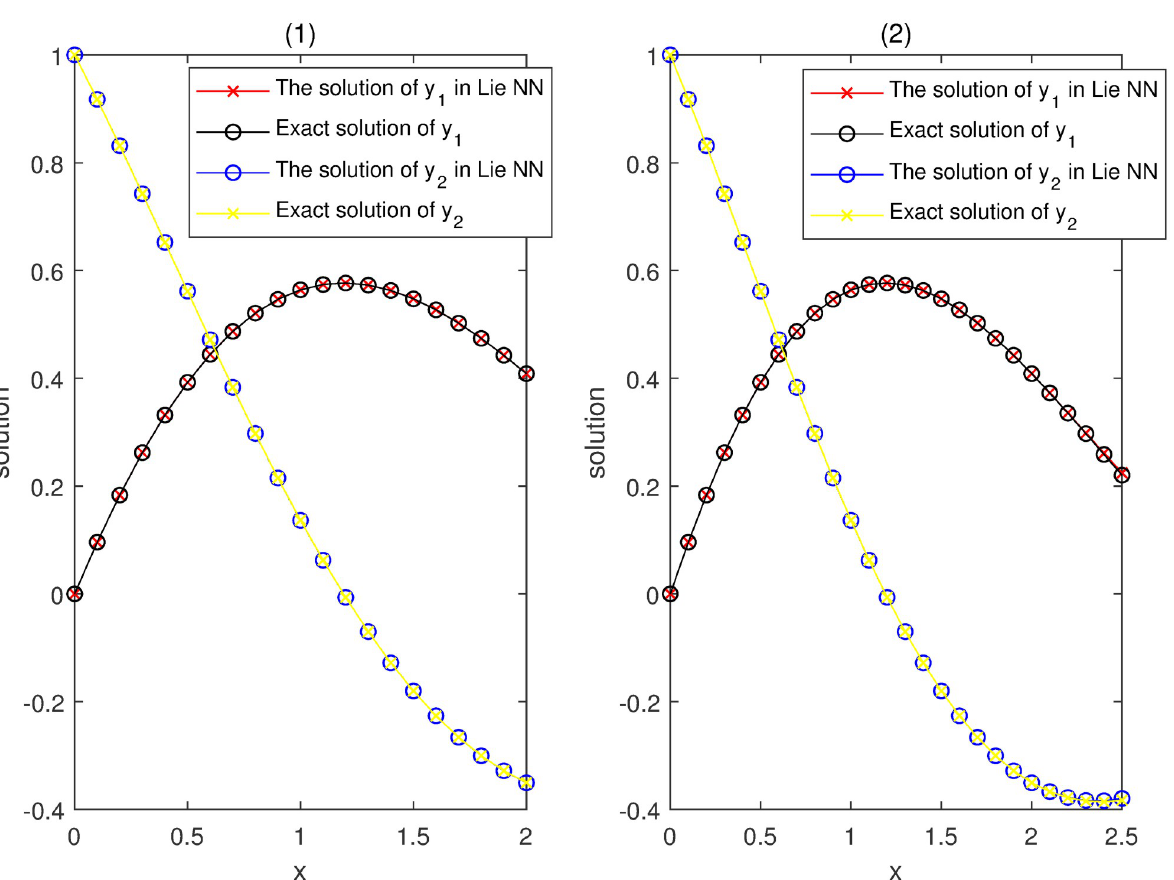
Fig 6. Comparison of the exact solutions y i and our ^ y